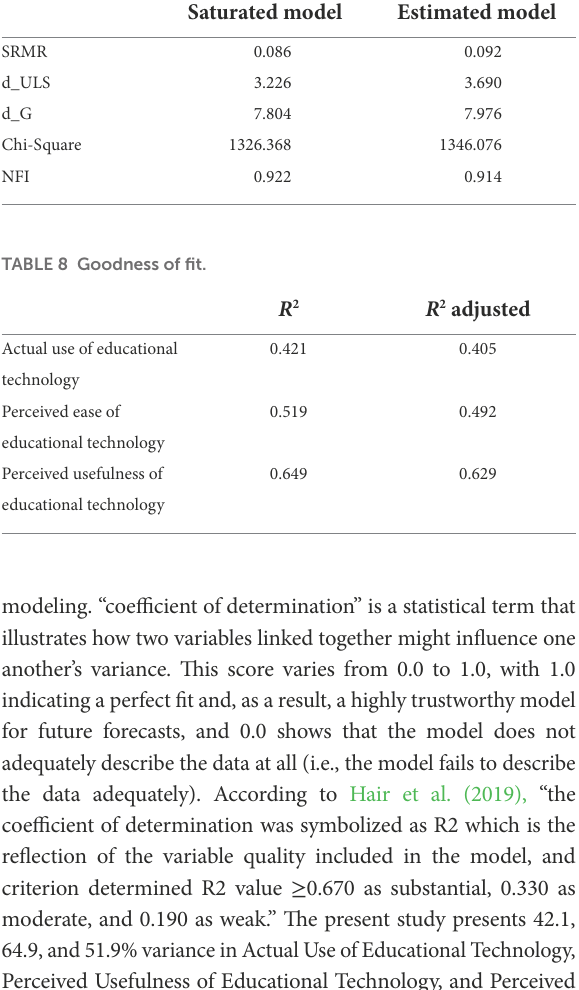
TABLE 7 Goodness of fit.